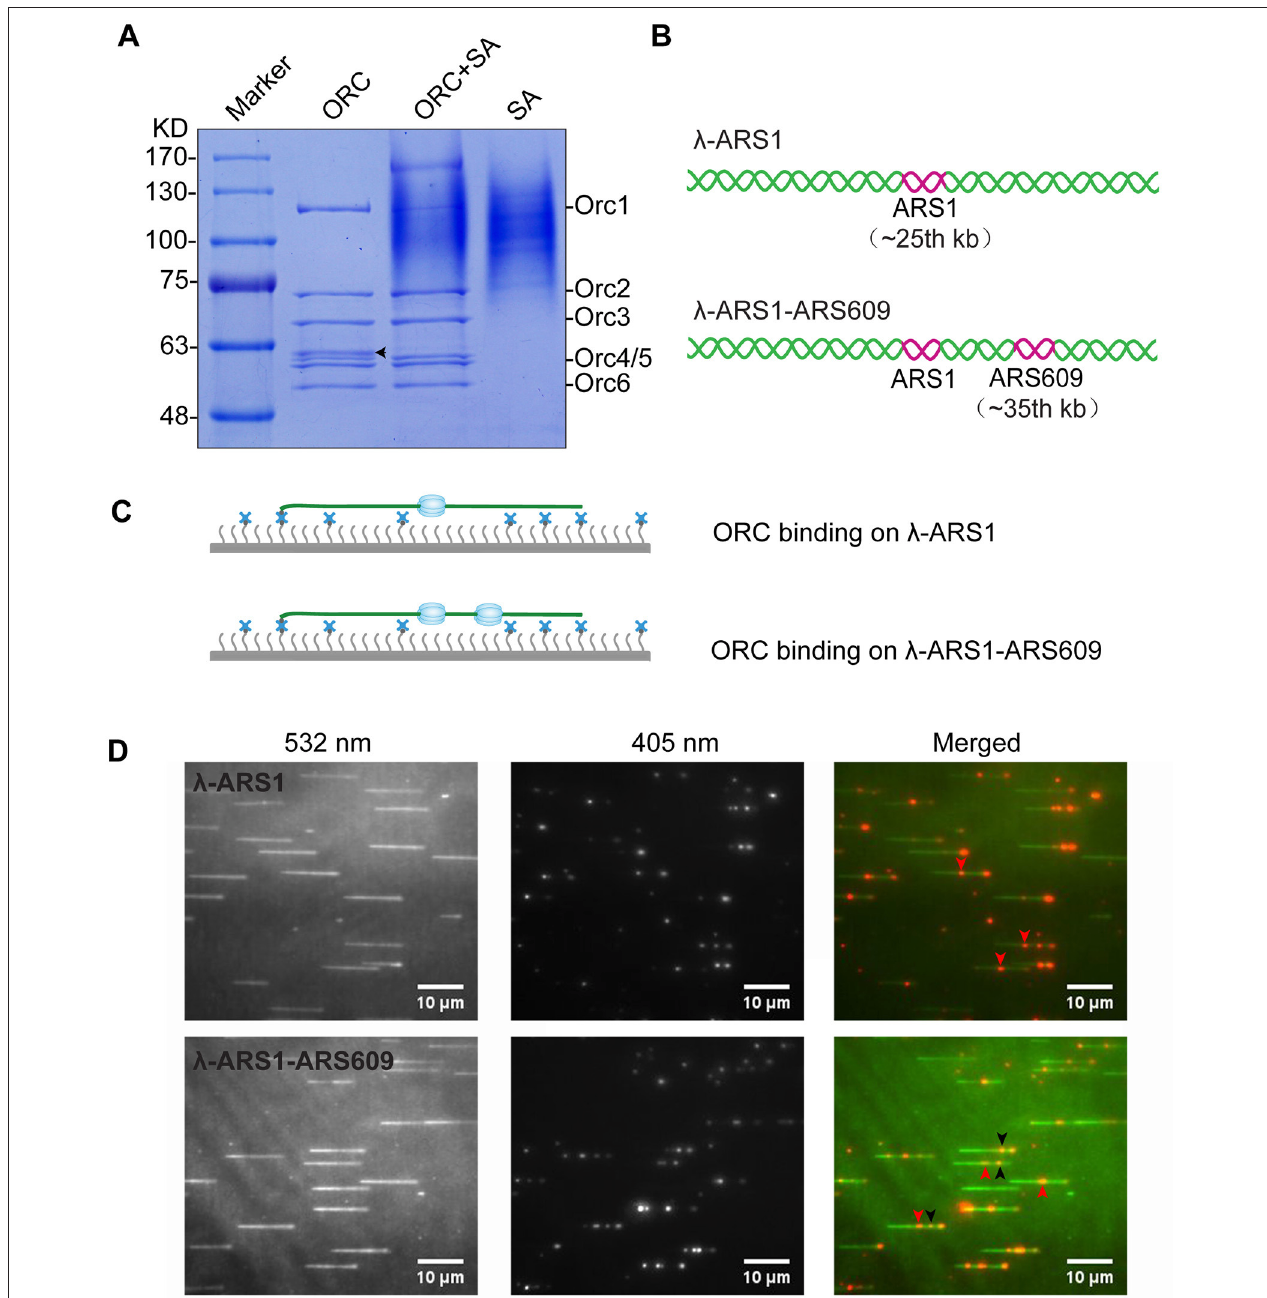
FIGURE 4 | ORC purification and single-molecule visualization. (A) Purified ORC and its biotinylation efficiency evaluation. Purified ORC (lane 1); ORC + unboiled streptavidin (SA) (lane 2); unboiled streptavidin (lane 3). 90% Orc1 was shifted in the presence of streptavidin in lane 3, which was quantified using Image J. The band appearing between Orc3 and Orc4/5 in lane 1 of (A) , indicated by a black arrow, was identified as the degradation band of Orc1 using MALDI-TOF mass spectrometry. (B) DNA substrates for ORC binding. An 838 bp DNA fragment containing ARS1 sequence was inserted into native lambda DNA at XbaI site (24, 508 bp) and named λ -ARS1; a 715 bp DNA fragment containing ARS609 sequence was inserted into at XhoI site (34, 336 bp) of λ -ARS1 and named λ -ARS1-ARS609. (C) ORC-Qdot 705 binding on λ -ARS1/ λ -ARS1-ARS609. DNA tethered on coverslip with the aid of the biotinylated oligonucleotide complementary to the left end of native λ DNA, together with flow in theory. (D) ORC-Qdot 705 binding on λ -ARS1 (top) and λ -ARS1-ARS609 (bottom). 0.5nM ORC-Qdot 705 was pumped into a flow cell with binding buffer. (Left) DNA was stained using SYTOX Orange and excited using a 532nm laser; (center) ORC-Qdot 705 was excited using a 405nm laser; (right) merged images. Three ORC binding positions at ARS1 and ARS609 inserted sites are indicated by red and black arrows, respectively.